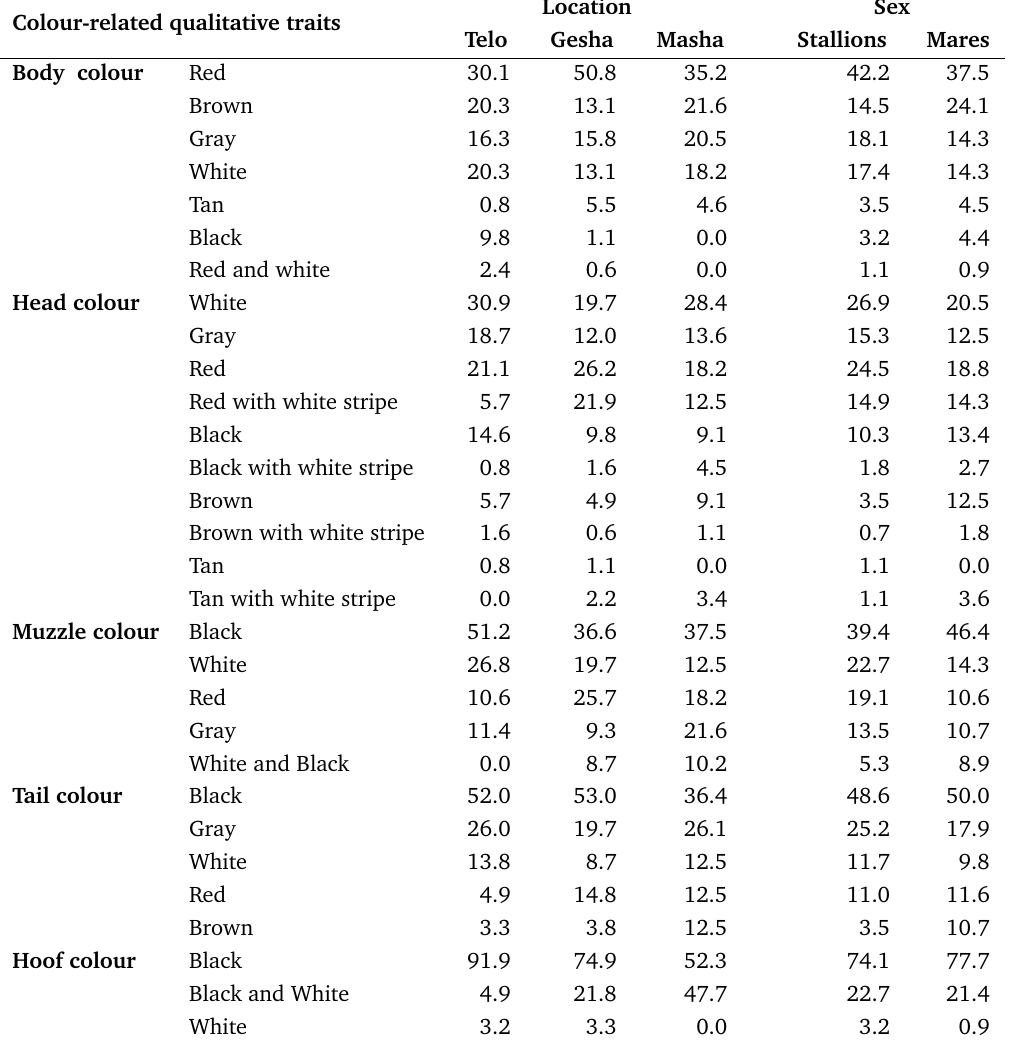
Table 15. Percentages of colour-related qualitative traits of the horses (both sexes) from different